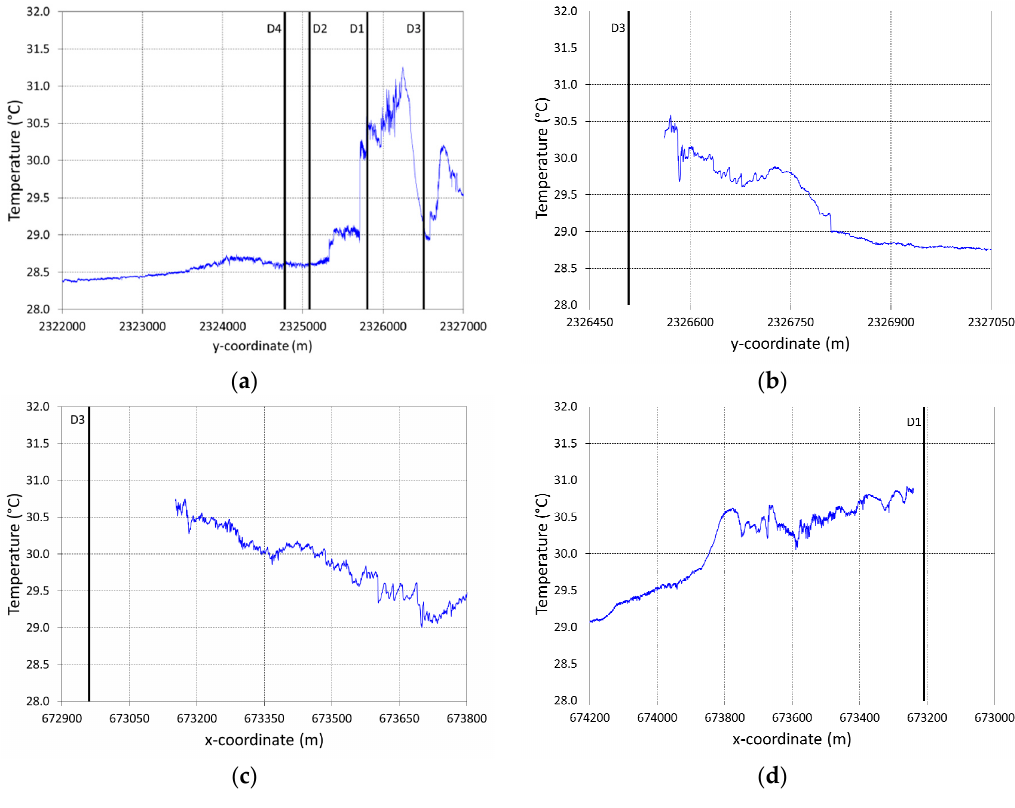
Figure 9. Sea surface CTD temperature measurements in front of the CTPALM. Solid lines show the location of the discharges. ( a ) First trace; ( b ) Second trace; ( c ) Third trace; ( d ) Fourth trace.